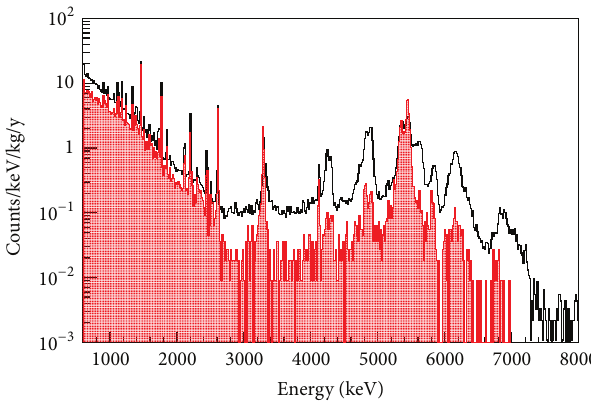
Figure 11: Comparison of Cuoricino (black histogram) and CUORE-0 (red filled histogram) background spectra. Preliminary result from